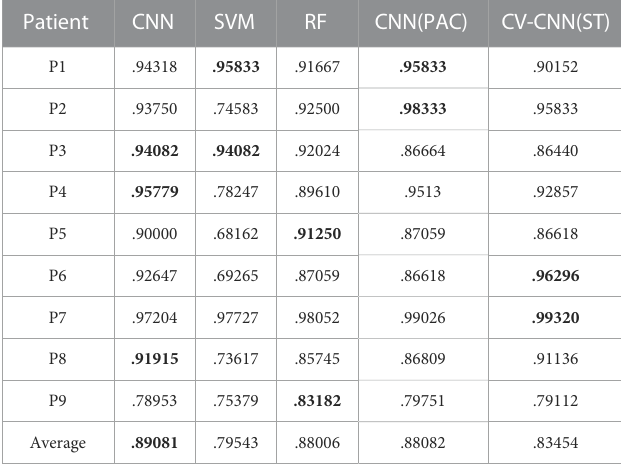
TABLE 3 Comparisons of AUC values by using CNN, SVM, RF, CNN(PAC), and CV- CNN(ST).